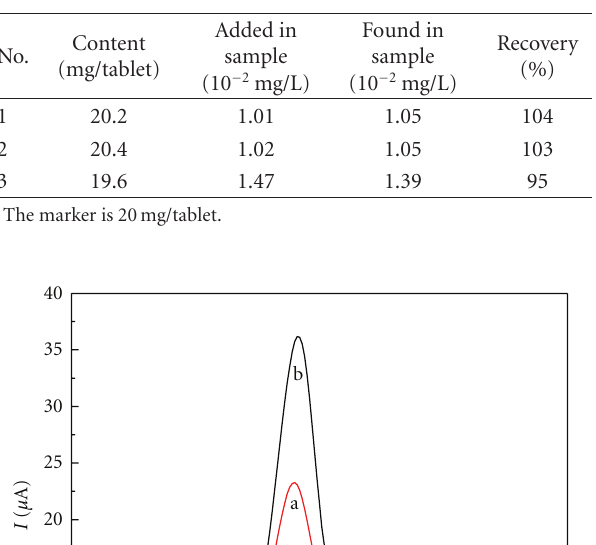
Table 2: Determination of rutin in tablet ∗ .